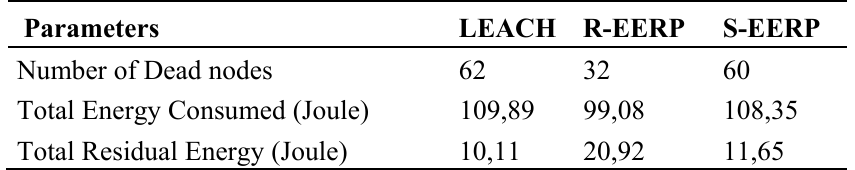
Table 4. Number of dead nodes, total energy comsumption and residual energy after 1,000